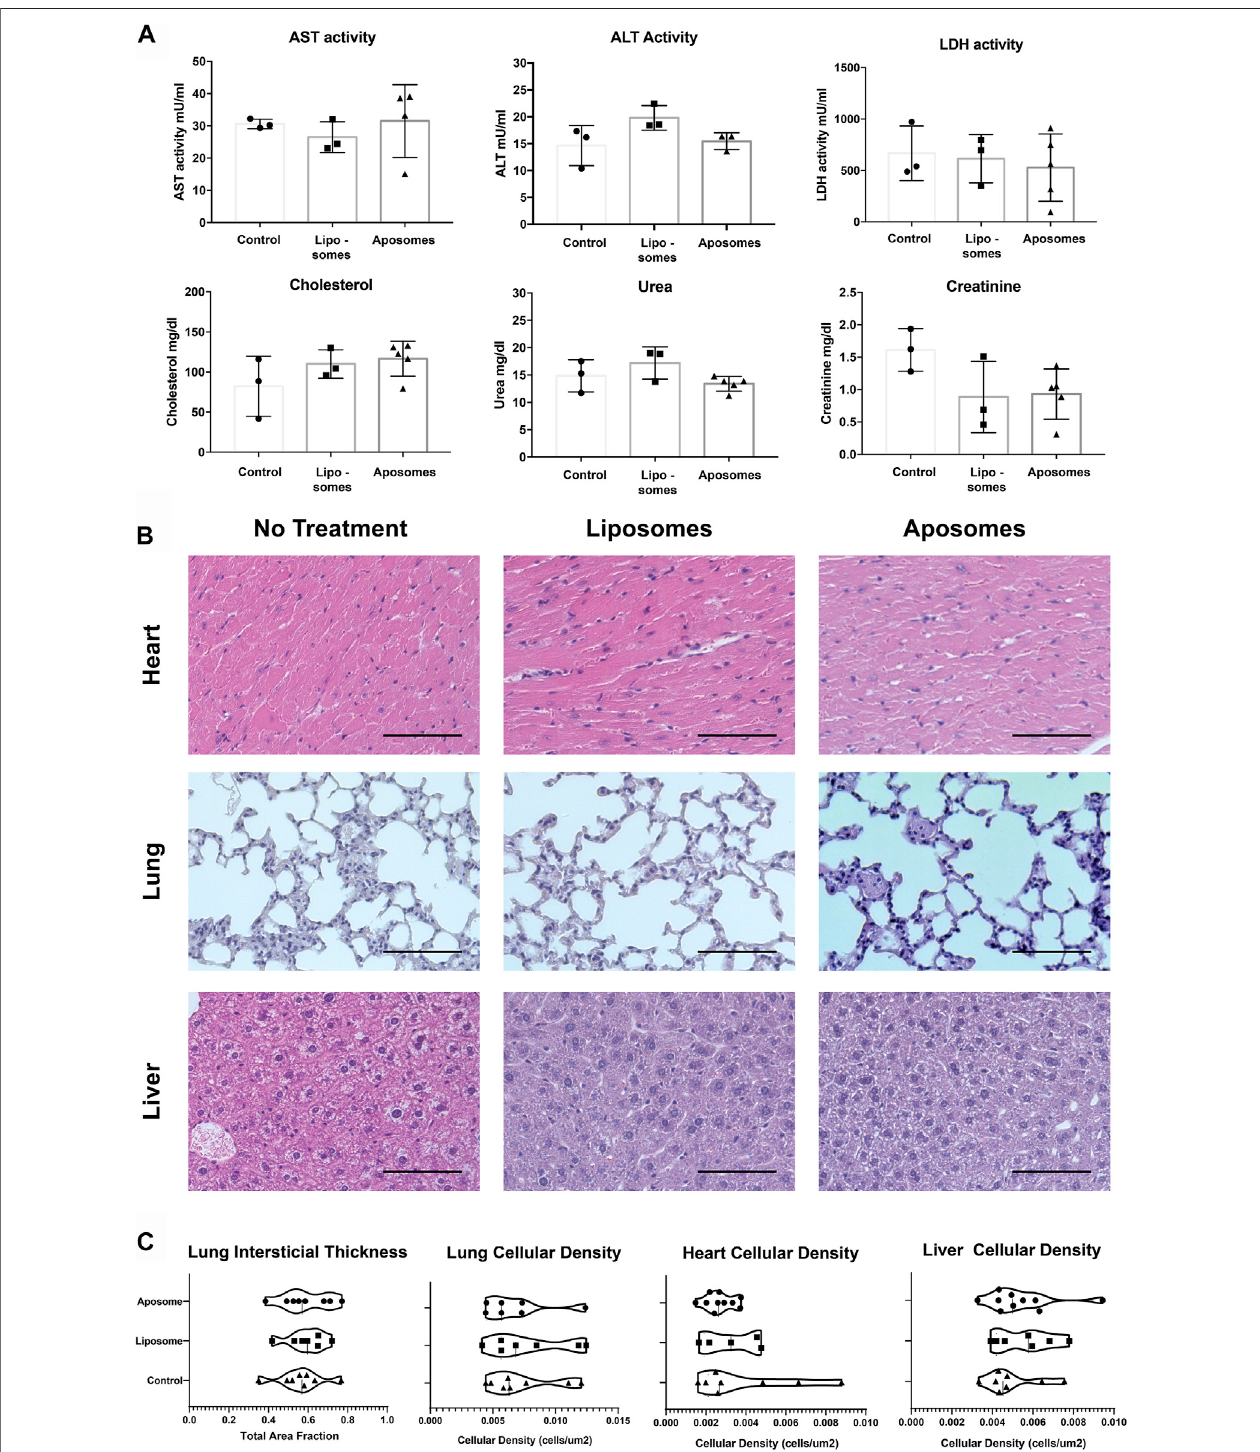
FIGURE 5 | Injected aposomes induce no observable alterations of metabolic panel or tissue macrostructure in mice – (A) metabolic panel of mice injected with aposomes show no alterations in key metabolic markers, corroborating the biocompatibility of aposomes (B) H&E staining of heart, lung, liver tissue shows no abnormalities of interest (C) Semiautomated morphological analysis of heart, lung, and liver show no signi fi cant difference in cellular density among groups with no treatment and those treated with liposomes and aposomes. Scale bars (cid:2) 100 um.